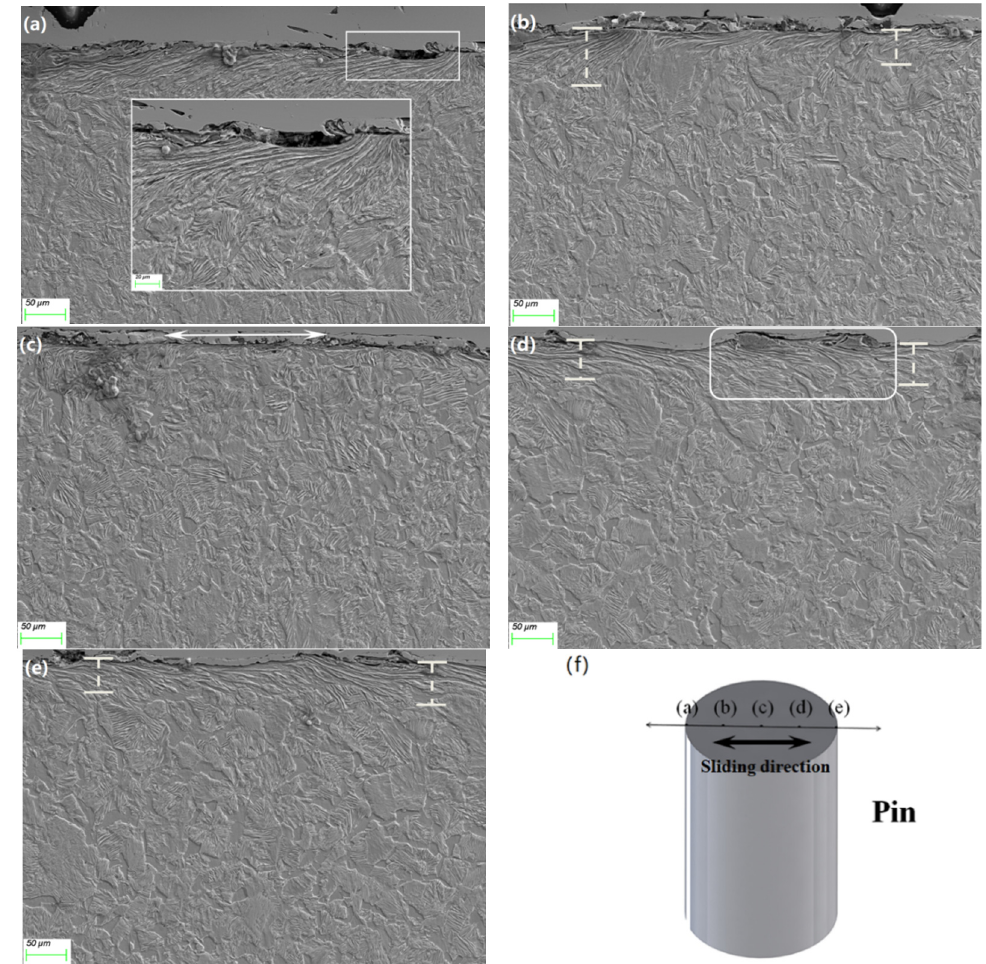
Figure 8. Cross-sectional microstructures of 40Cr pin after reciprocating 120 min sliding: ( a ) left edge area, ( b ) left quarter area, ( c ) central area, ( d ) right quarter area, ( e ) right edge area, ( f ) the sketch of the location of each quartering point.